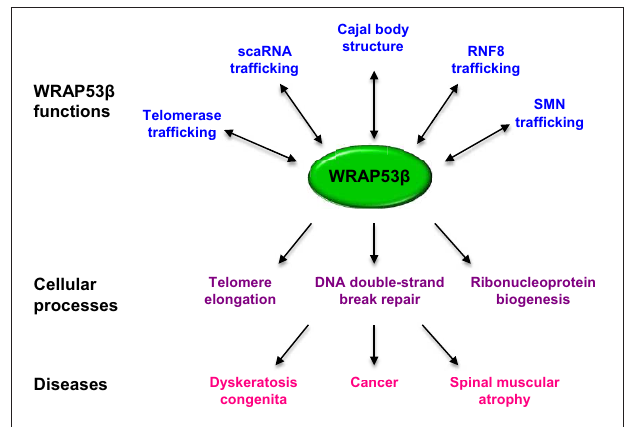
FIGURE 4 | Overview of the functions of WRAP53 β and associated cellular processes and